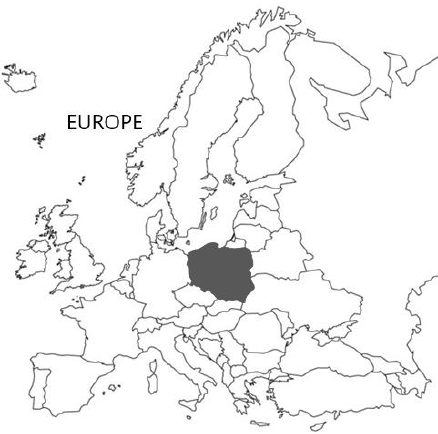
Figure 1. Poland on the map of Europe. Source: own research.